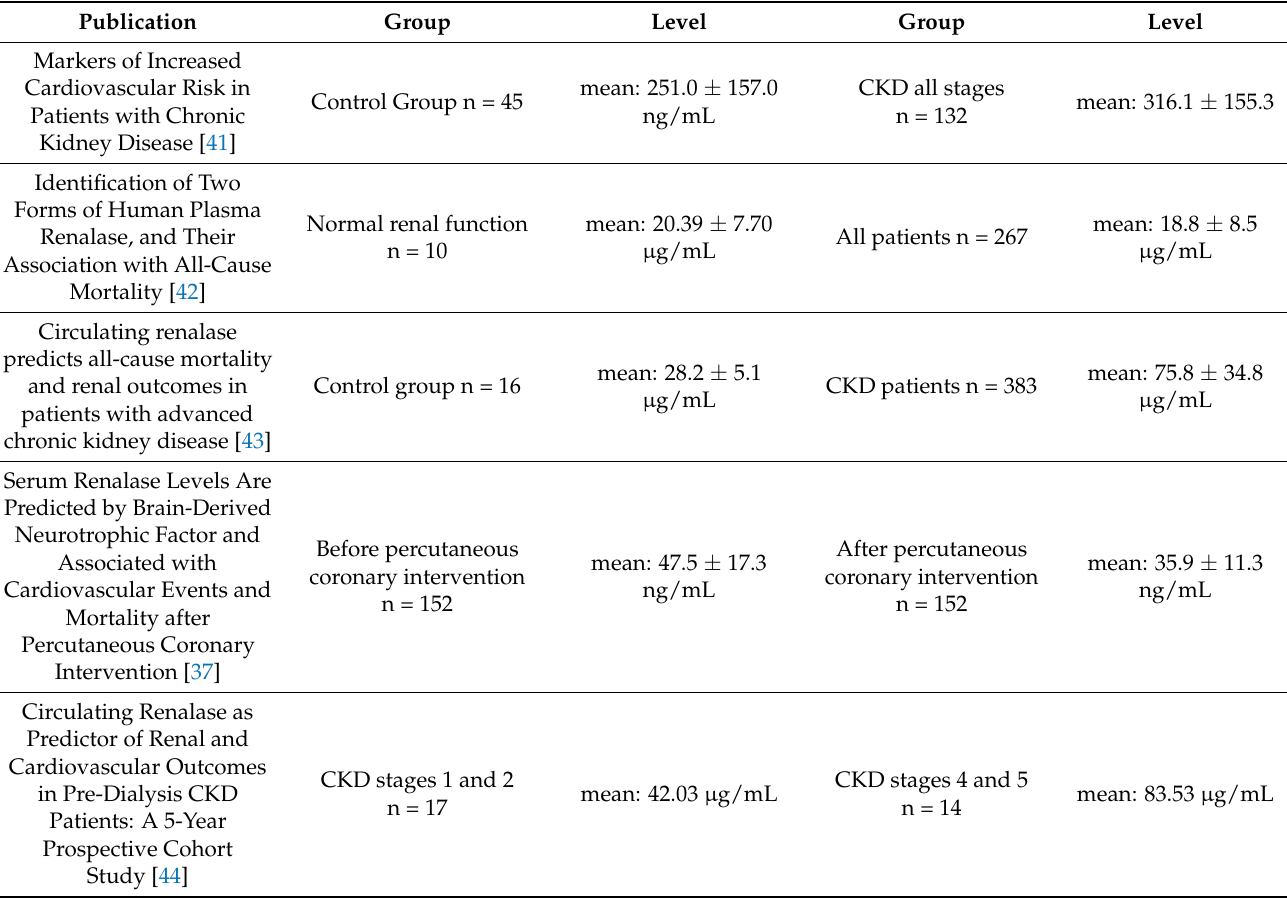
Abbreviations: CKD—chronic kidney